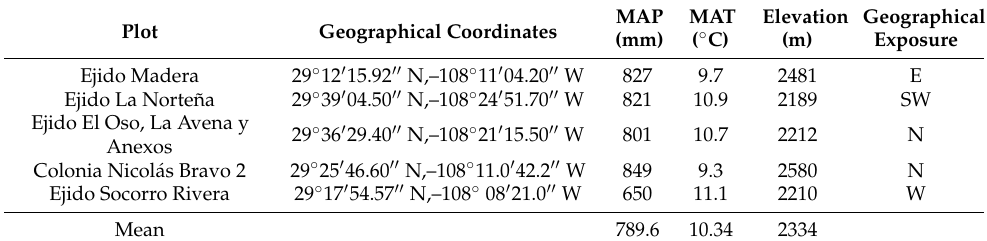
Table 1. Geographical coordinates of the plot samples in the study area. Plot